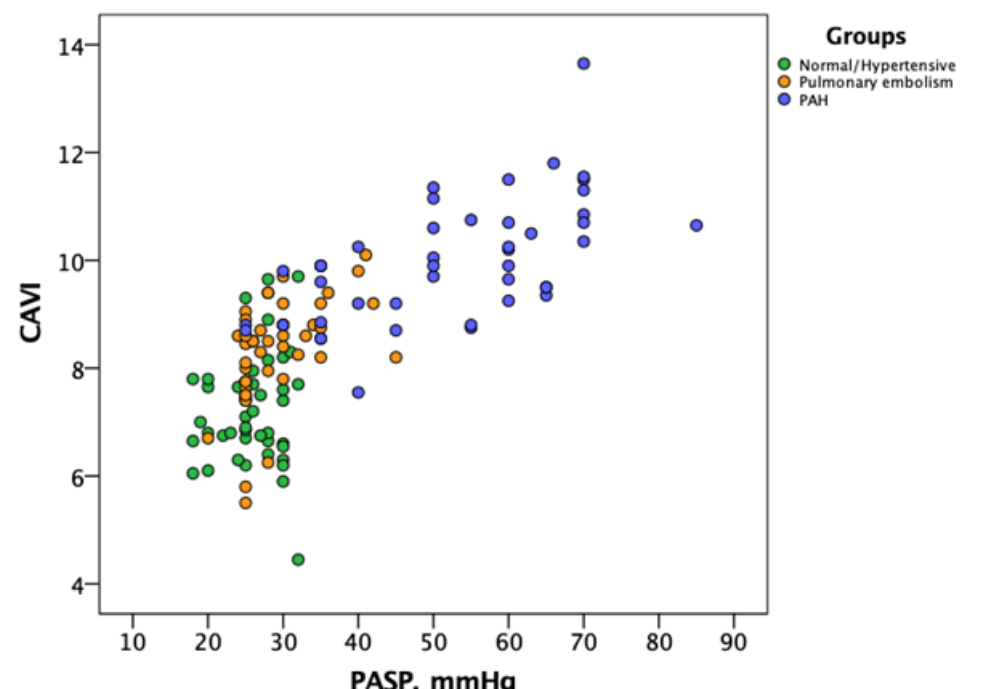
Figure 3. Correlation between CAVI (Y-axis) and echo-derived PASP (X-axis) based on patients cohort. The 4 groups of patients are reported in the same scatterplot. Group 1 (patients with acute pulmonary embolism): orange circles; Group 2 and Group 3 (healthy subjects and patients with systemic hypertension): green circles; Group 4 (patients with idiopathic pulmonary arterial hypertension): blue circles. Patients with pulmonary embolism and idiopathic pulmonary arterial hypertension present higher values of CAVI compared with normal and hypertensive patients. Abbreviations: CAVI: cardio-ankle vascular index; PASP: pulmonary arterial systolic pressure.